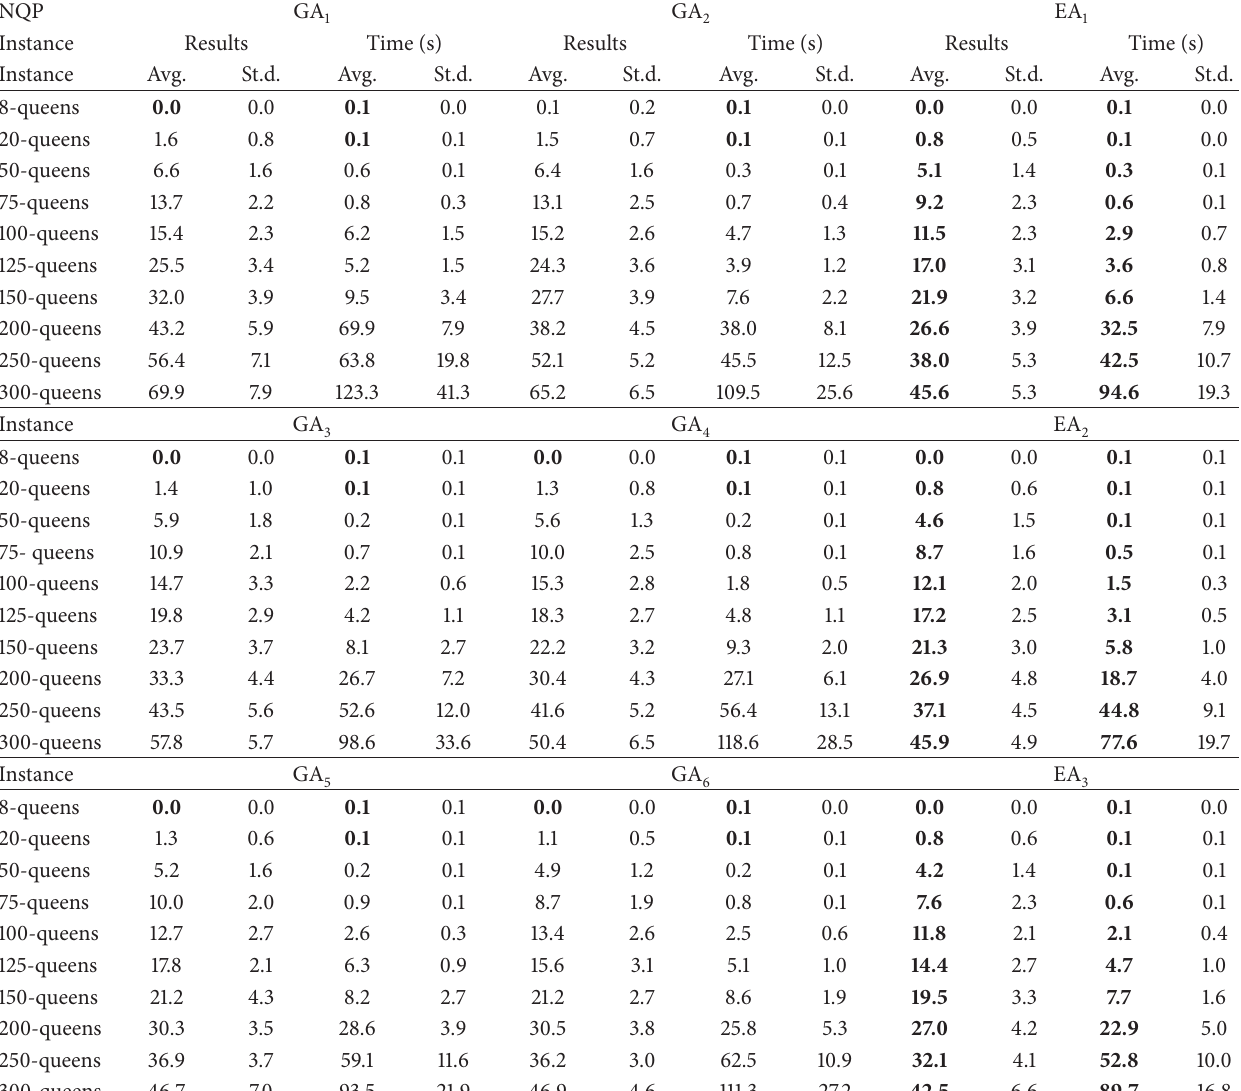
Table 8: Results and runtime of the nine techniques applied to the NQP. For each instance, the results, average runtime, and their standard deviations are